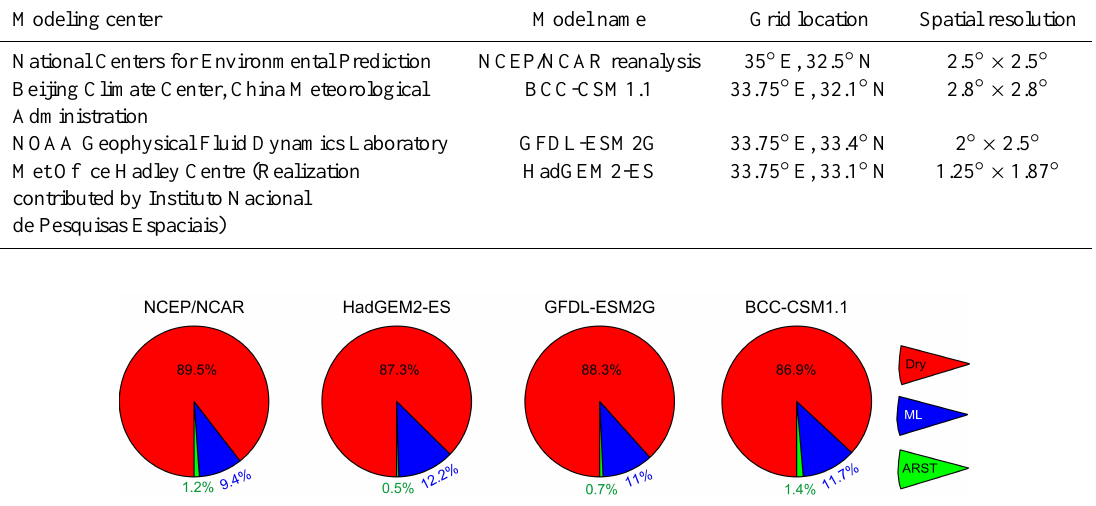
Figure 2. Annual average of 6h occurrence frequency of dry, ML, and ARST synoptic systems derived from the NCEP/NCAR reanalysis data and the three GCMs used in this study for the historical period (after Peleg et al., 2014). The GCMs slightly overestimate the wet synoptic systems frequency by 2.1% (HadGEM2-ES), 1.2% (GFDL-ESM2G) and 2.5%